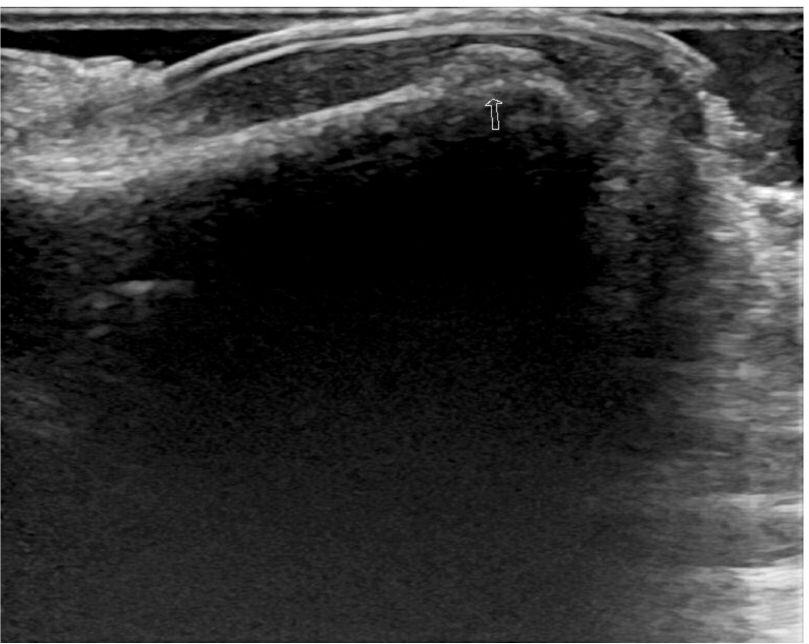
Figure 2. Unilateral foot ultrasonography: Cortical disruption at the dorsal aspect of right first distal phalanx (arrow).